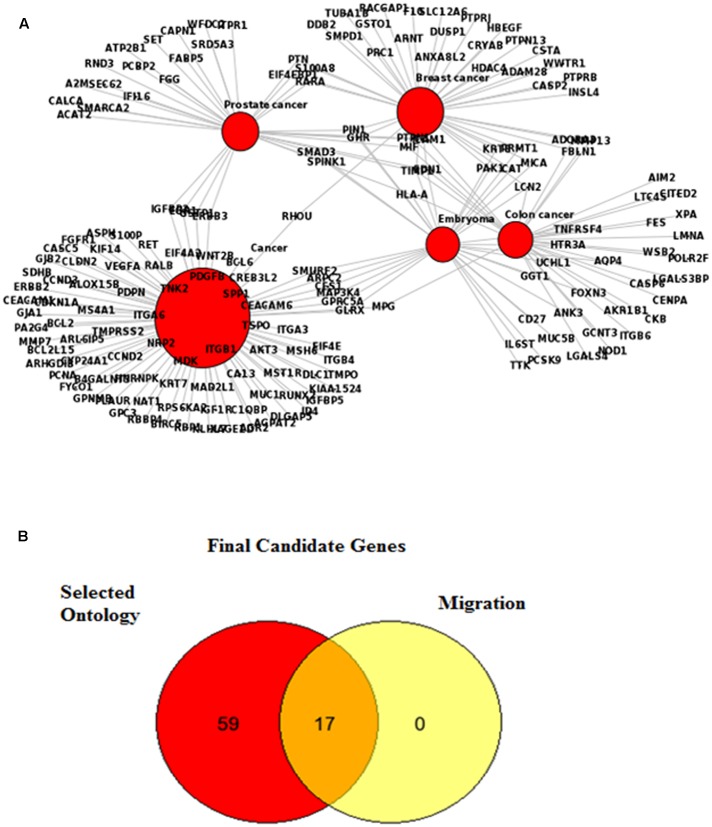
FunDO analysis revealed the molecular networks for various cancers. (A) Genes such as SMAD3, HLA-A, S100A8 and RHOU were common in prostate, breast and colon cancers. (B) Venn diagram showing the 17 candidate genes involved in migration as well as other common ontology in cancers.